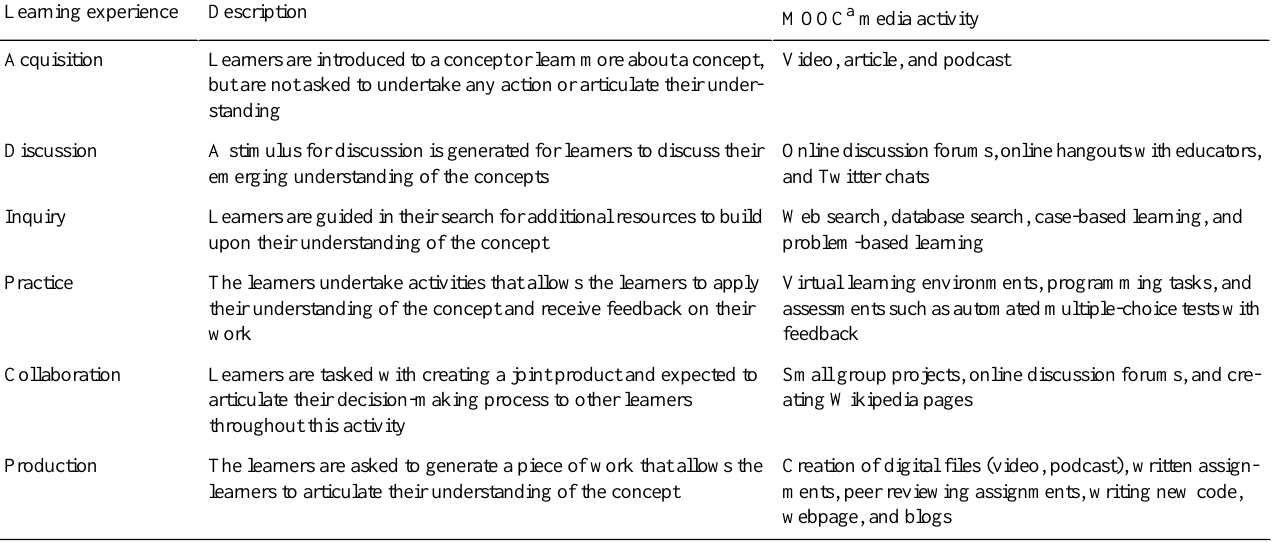
Table 2. Categorization of massive open online course media activity by learning